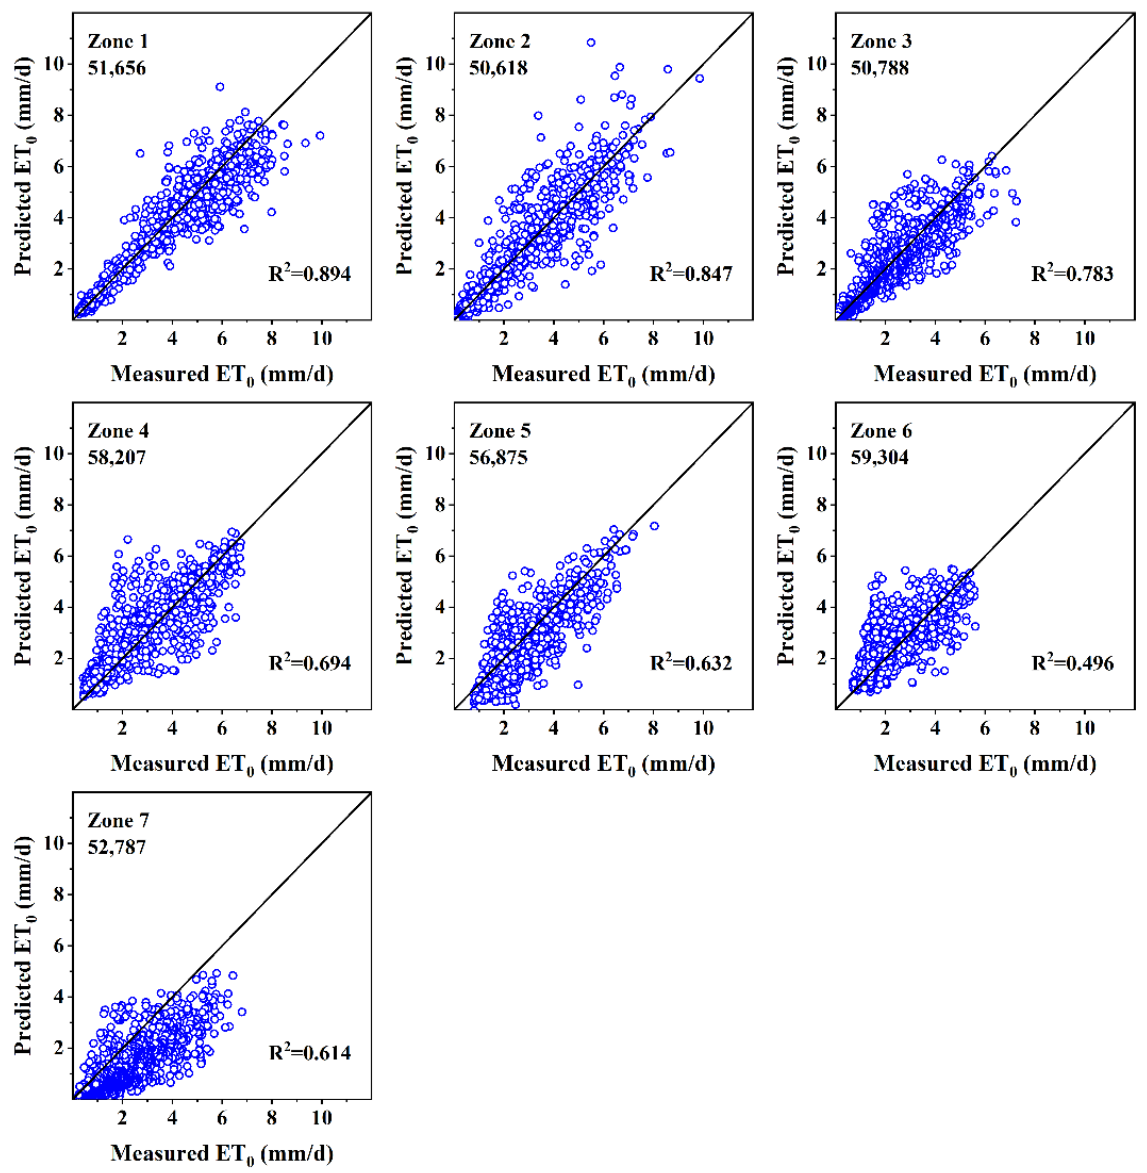
Figure 6. Scatter plots of CLDAS and FAO56 PM values of ET 0 in different climates.